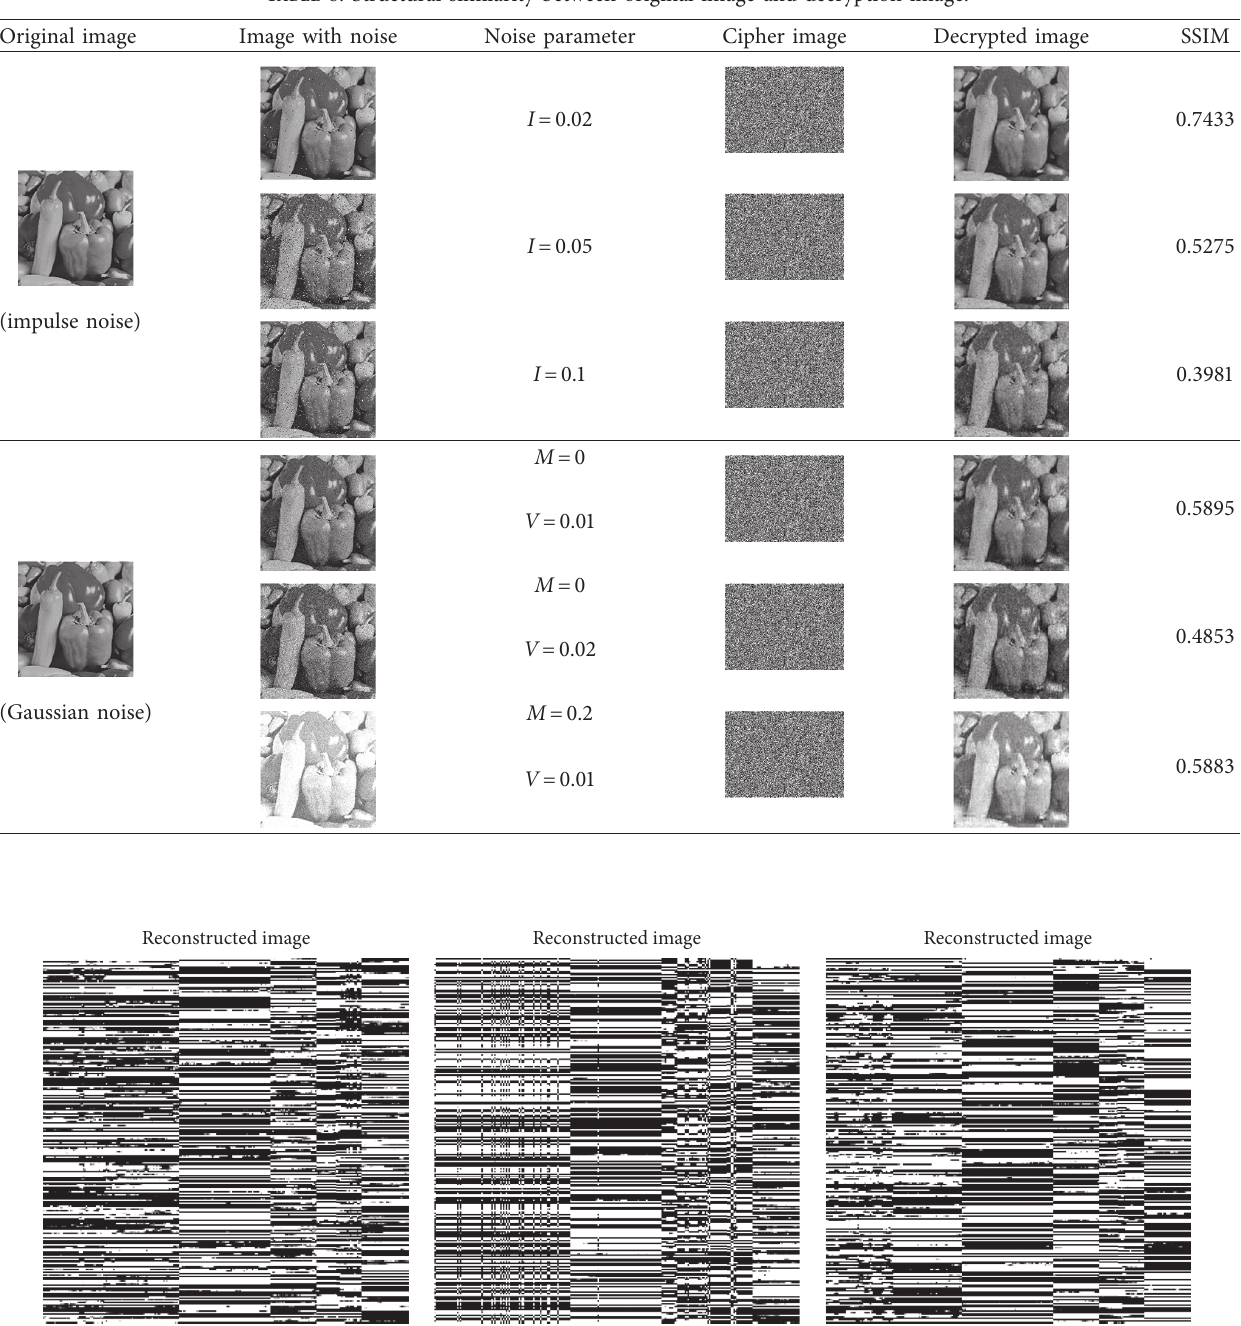
Table 8: Structural similarity between original image and decryption image.